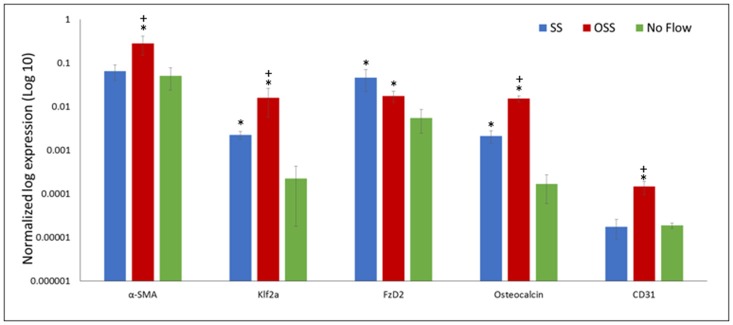
Gene expression follows 48 h of HBMSCs exposure to PSS, SS, and no flow groups. Error bars are displayed as ± SEM; (n = 4). Of particular importance is the significantly greater (p < 0.05) expression of klf2a found in the PSS-treated cells compared to SS and no flow groups; klf2a, a critical gene regulated by PSS, is required for normal valve development and whose absence results in valvular defects. *indicates a significant difference (p < 0.05) between the flow groups (SS and/or PSS) and the no flow controls. +indicates the PSS flow group is significantly different (p < 0.05) compared to the SS flow group.